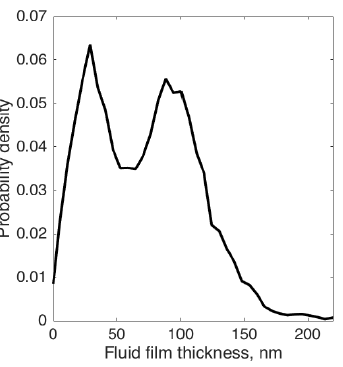
Figure 6. Probability distribution of fluid film thicknesses along the rim of Crystal